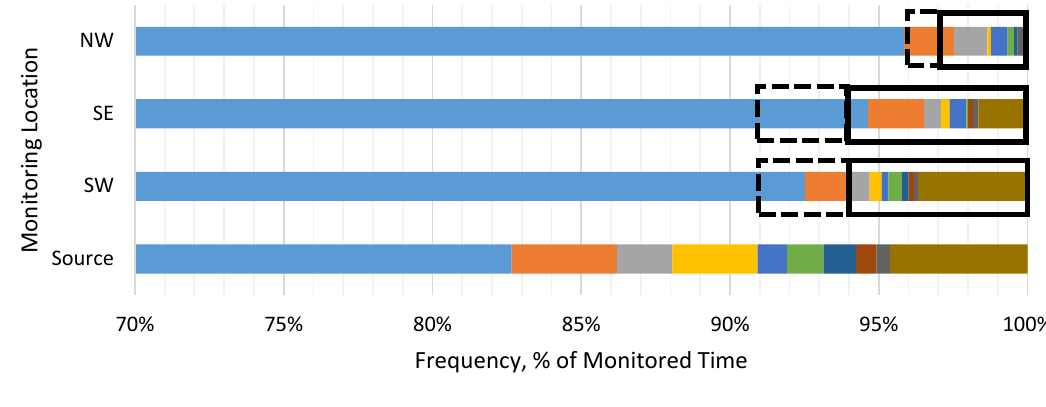
Figure 6. Cumulative frequency of hydrogen sulfide concentration measurement ranges from low to high (in 10 ppb increments) at the monitoring locations for the dairy case study. The dashed black boxes indicate the range of time when the South Dakota Odor Footprint Tool estimates the onset of odor annoyance for the distance away from the source (dairy farm), and the black boxes indicates the remainder of the range of time of odor annoyance from onset.